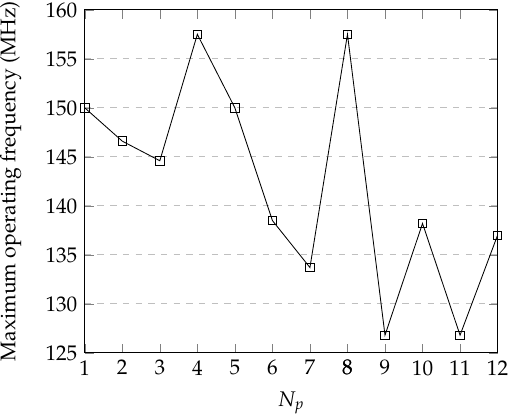
Figure 18. Maximum operating frequency for different number of